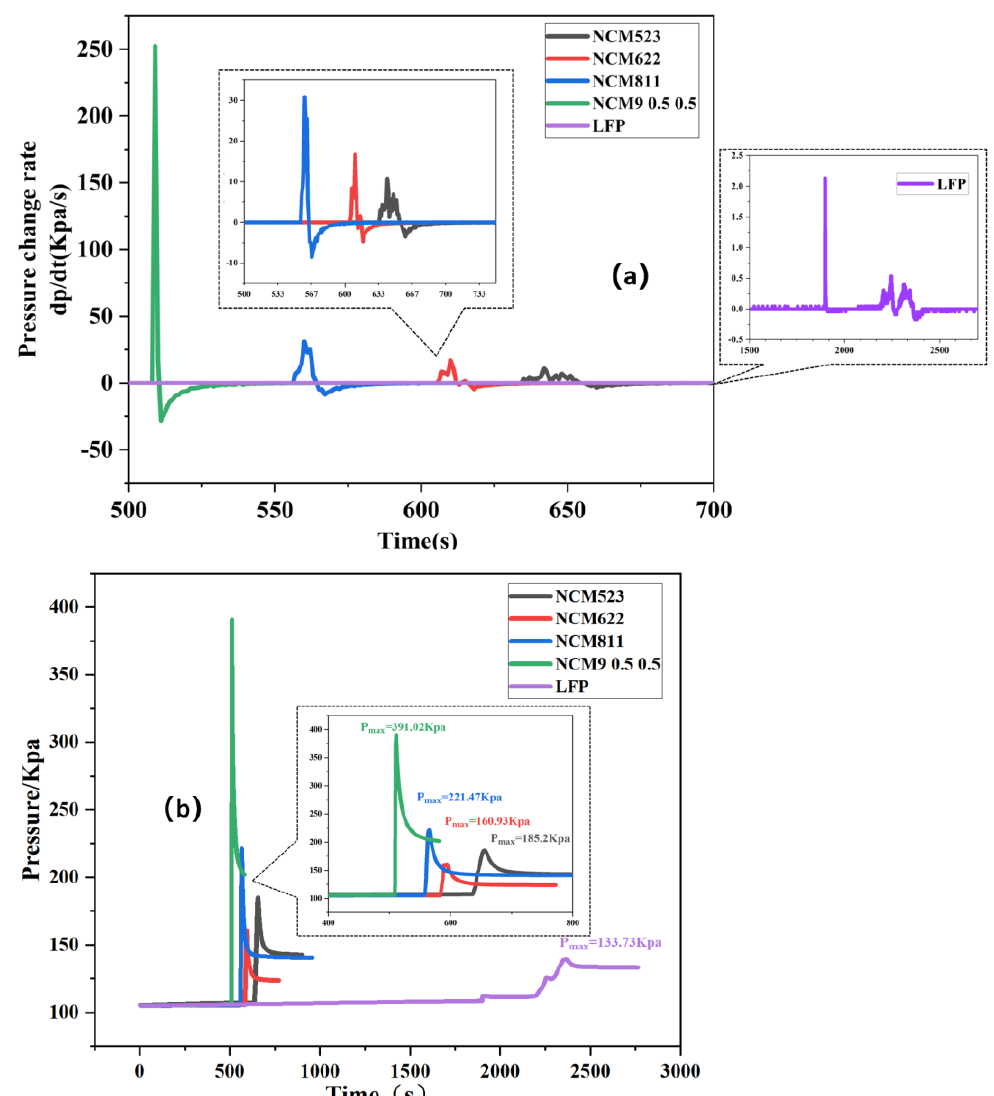
Figure 6. Pressure change rate ( a ) and pressure ( b ) in AEC chamber during TR of batteries with different cathode materials.